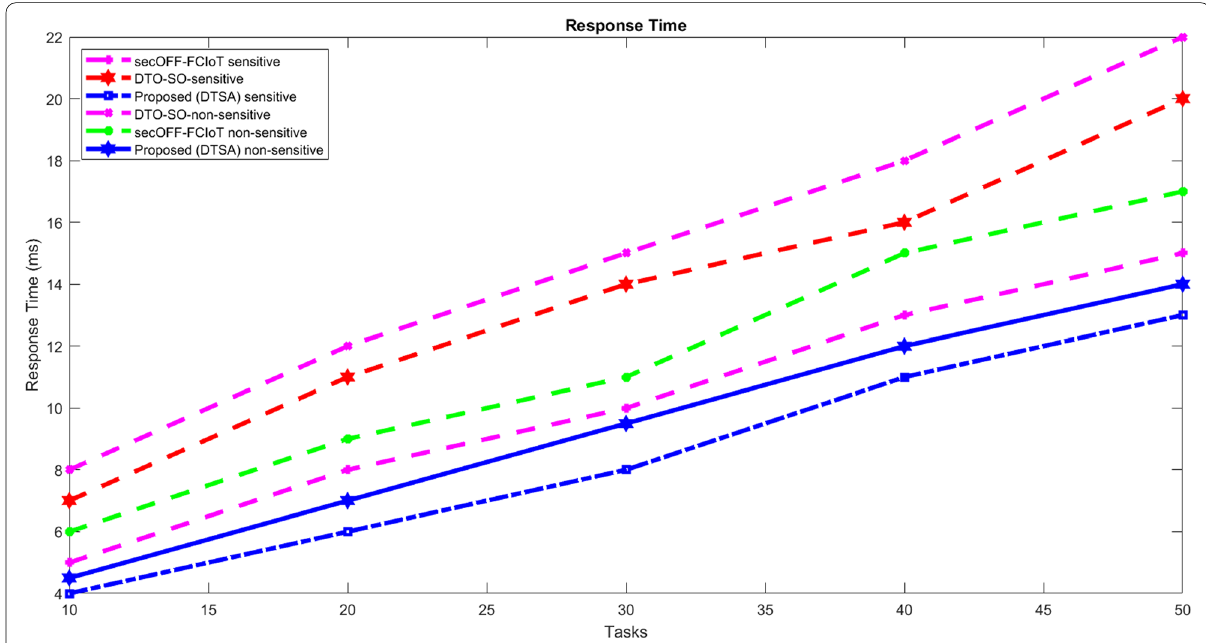
algorithm response time for the non-sensitive task is 9.5